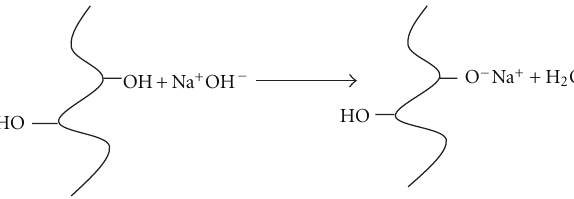
Figure 5: Alkali treatment reaction of cellulose-based fibers with